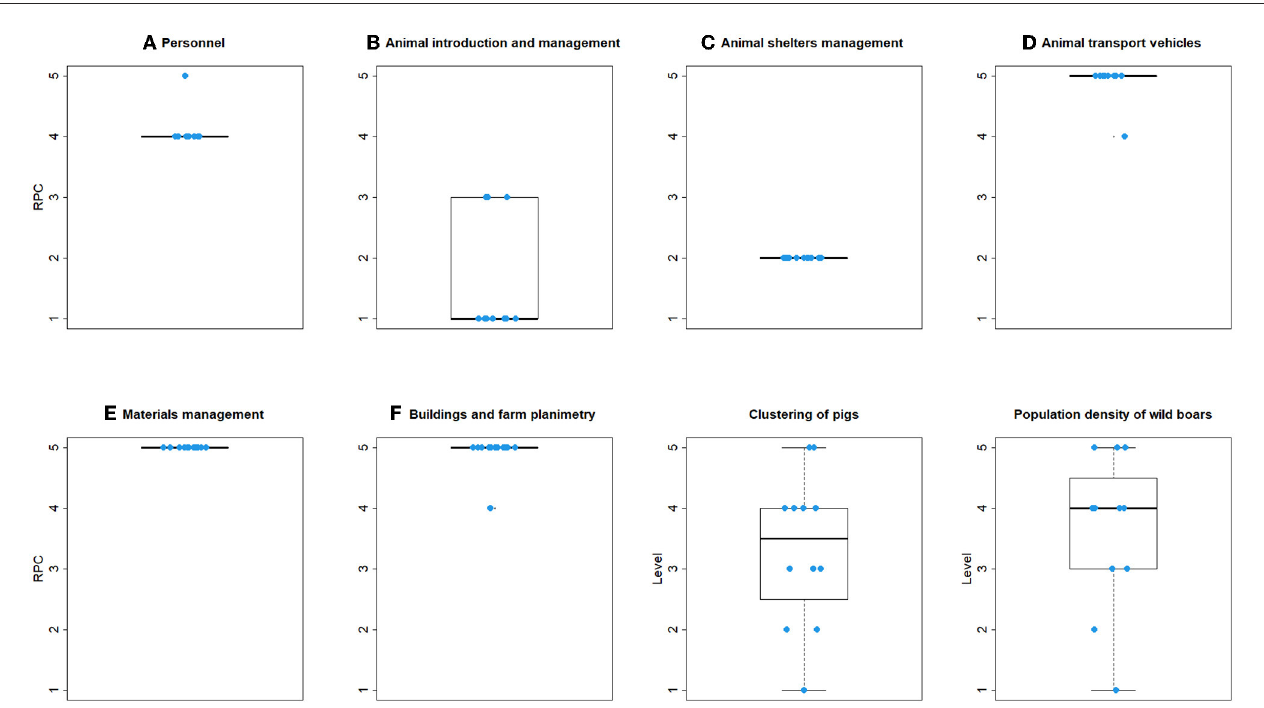
FIGURE5 Boxplot of the distribution of risk priority codes (RPC) for each criterion, obtained by the application of FMEA, local density of pigs, and wild boar population density, estimated in 12 non-commercial and small commercial pig farms in Italy. In the boxes, the thick horizontal line represents the median risk priority code, whereas the base and the top of the boxes are the first, and third quartiles, respectively. Whiskers extend to a maximum of 1.5 times the interquartile range. Points represent extreme values. Blue circles represent individual farm’s RPC’s.